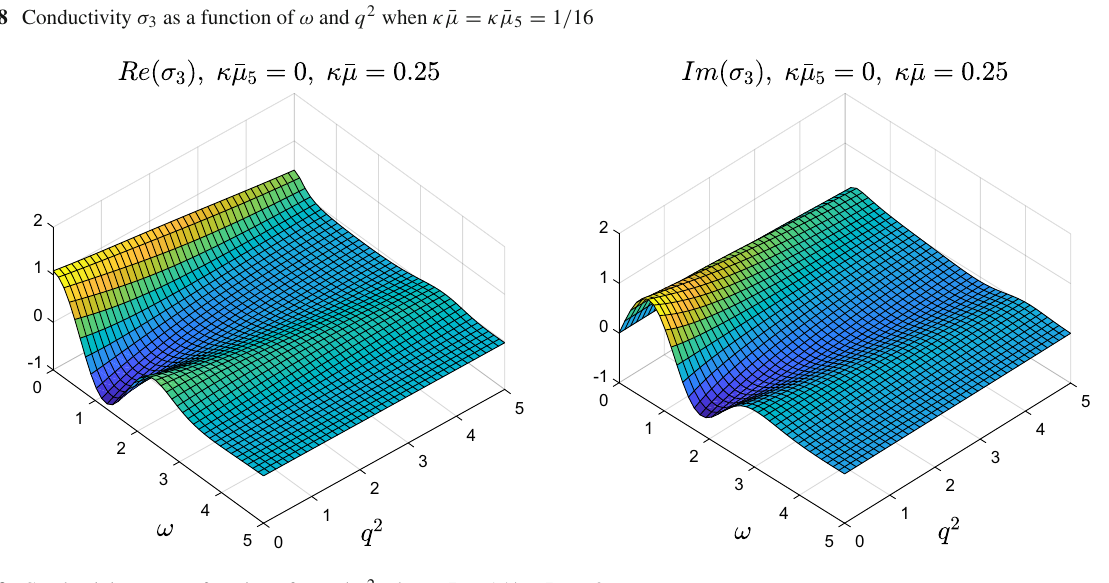
Fig. 19 Conductivity σ 3 as a function of ω and q 2 when κ ¯ μ = 1 / 4, κ ¯ μ 5 = 0